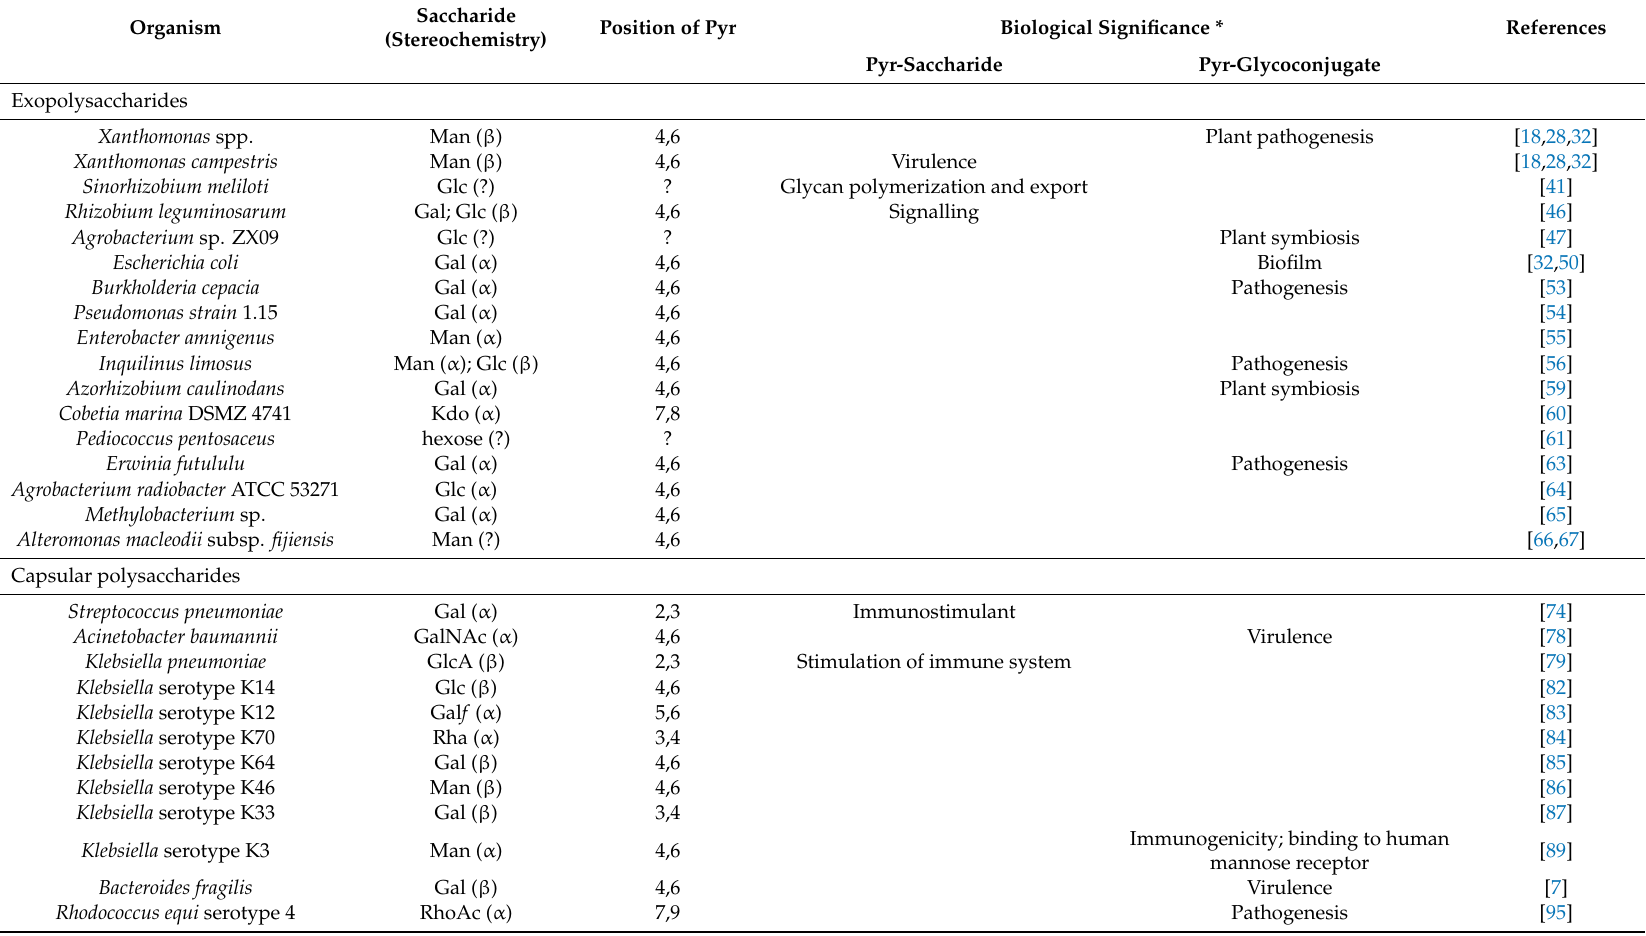
Table 1. Pyruvylated saccharides and positions of pyruvate found in the organisms described in this review. Saccharide Organism Position of (Stereochemistry)